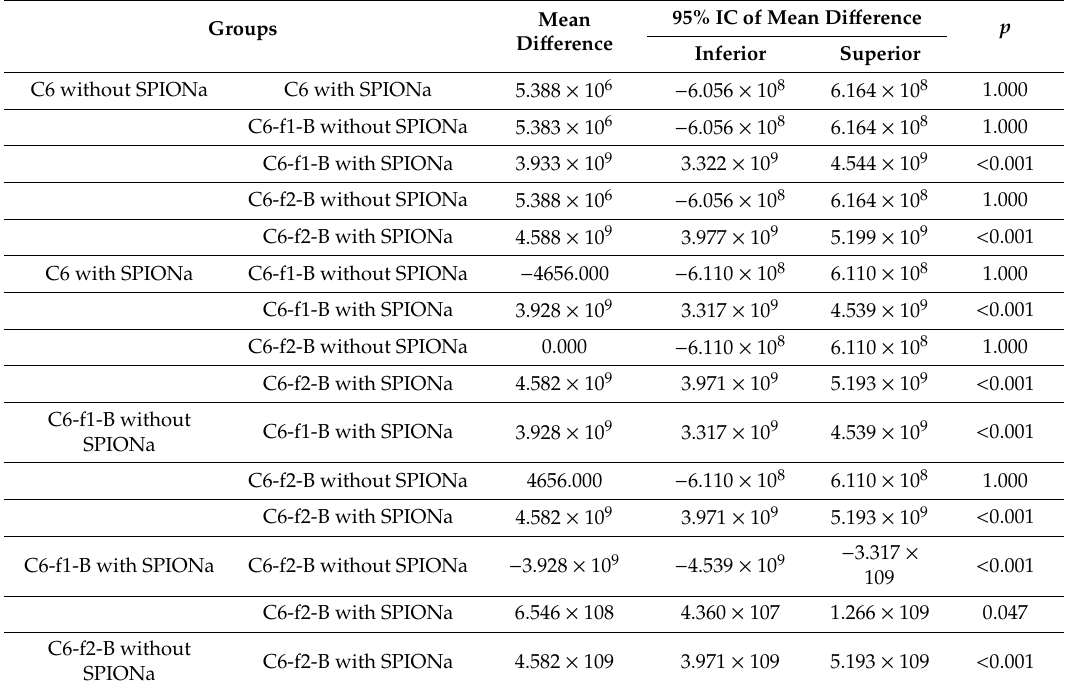
Table A3. Post Hoc analysis of the BLI signal of experimental groups in the second MHT application.